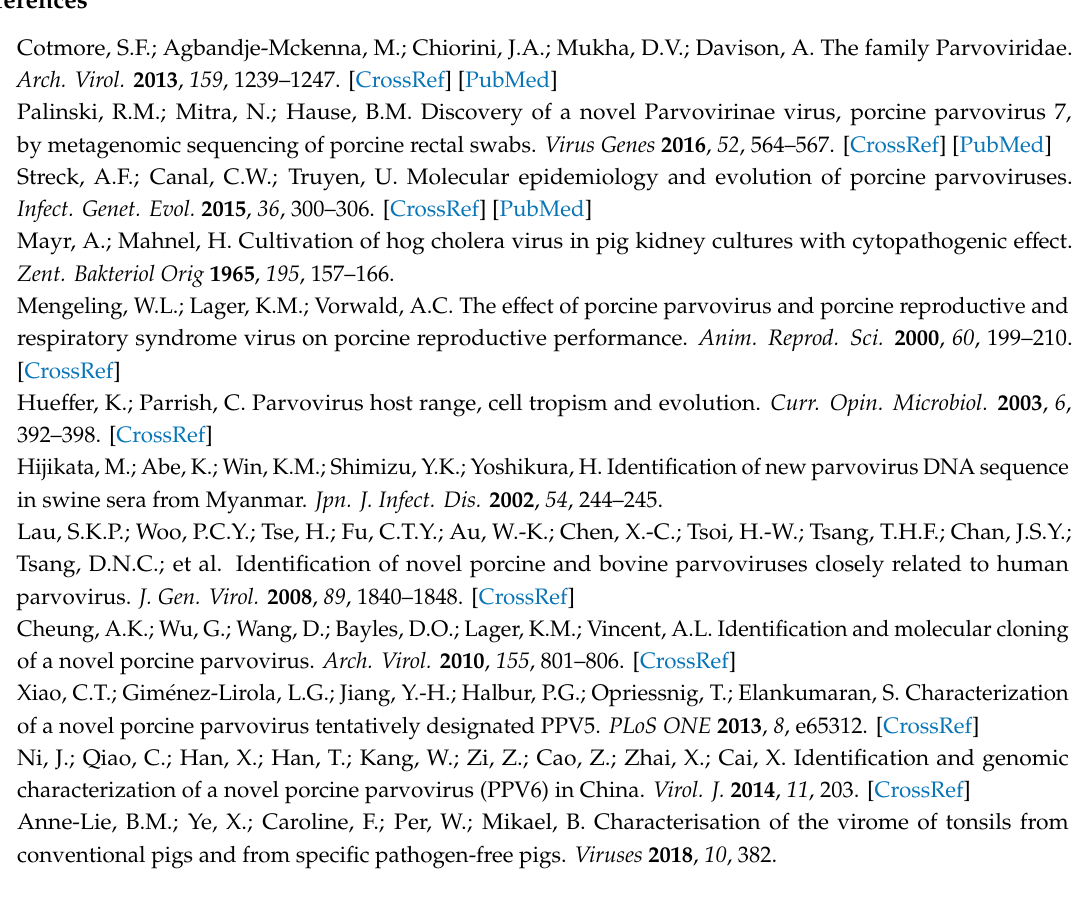
Figure S1: Phylogenetic analysis of viruses in the Parvoviridae family, Figure S2: Secondary structure analysis of PPV7 Cap via PSIPRED, Figure S3: Sequence alignment of PPV7 Cap, Figure S4: Mapping the location of identified PPV1 B cell epitope regions on 3D structure (PDB ID: 1K3V) of capsid (A) and Cap monomer (B,C), Figure S5: 2D graphical representation of molecular interaction analysis of MHC class-I alleles binding peptides to SLA-2*0402 (A) and SLA-3*0401 (B) protein, Table S1: Detailed information of PPV7 strain sequences used in this study, Table S2: Detailed information of reference Parvoviridae sequences used in this study, Table S3: Identified linear B cell epitopes in PPV1 Cap deposited in IEDB database, Table S4: CD8 T cell epitopes prediction of PPV7